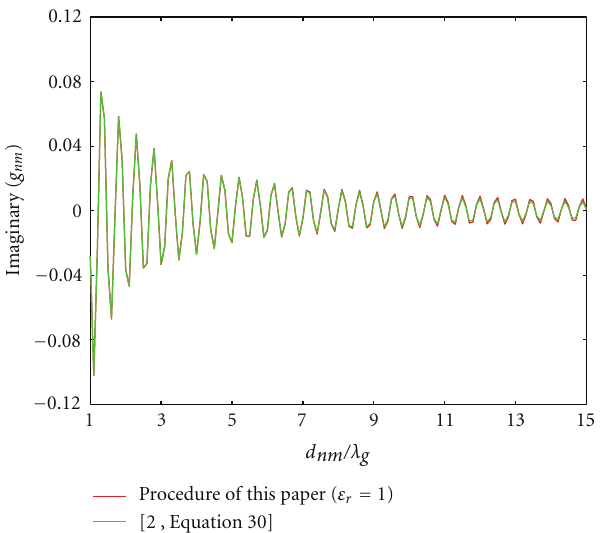
Figure 3: Imaginary part of the mutual coupling coe ffi cient g nm , θ = 45 ◦ .